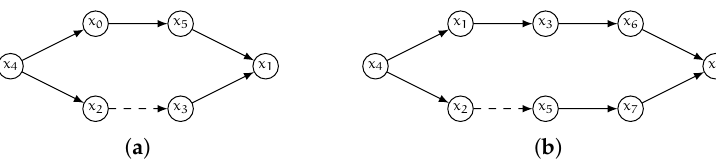
Figure 5. ( a ): an example of the contradiction reached in the proof of Property 3. Suppose vertex ordering is { x 0 , x 1 , x 2 , ... , x 5 } and all arcs weight 1 for the sake of the example. Therefore, in any ) cannot belong to L out ( x 4 ) . This allows minimal well-ordered 2- HOP - COVER labeling entry ( x 1 , δ x 4 x 1 Algorithm CLEAN to avoid removing correct entries. ( b ): a case where a correct entry is preserved by Algorithm CLEAN . Suppose the vertex ordering is { x 0 , x 1 , x 2 , ... , x 7 } and all arcs weight 1 for the sake of the example. Therefore in any minimal well-ordered 2- HOP - COVER labeling, L out ( x 4 ) will contain ( x 0 , δ x ) with δ x = d ( x 4 , x 0 ) = 4 . Clearly, also L out ( x 1 ) and L out ( x 2 ) will contain. similarly, 4 x 0 4 x 0 entries ( x 0 , 3 ) and ( x 0 , 3 ) , respectively. If arc ( x 2 , x 5 ) undergoes some decremental update, the (correct) entry in L out ( x 4 ) is not removed thanks to the presence of the alternative shortest path through x 1 with the same weight as that through x 2